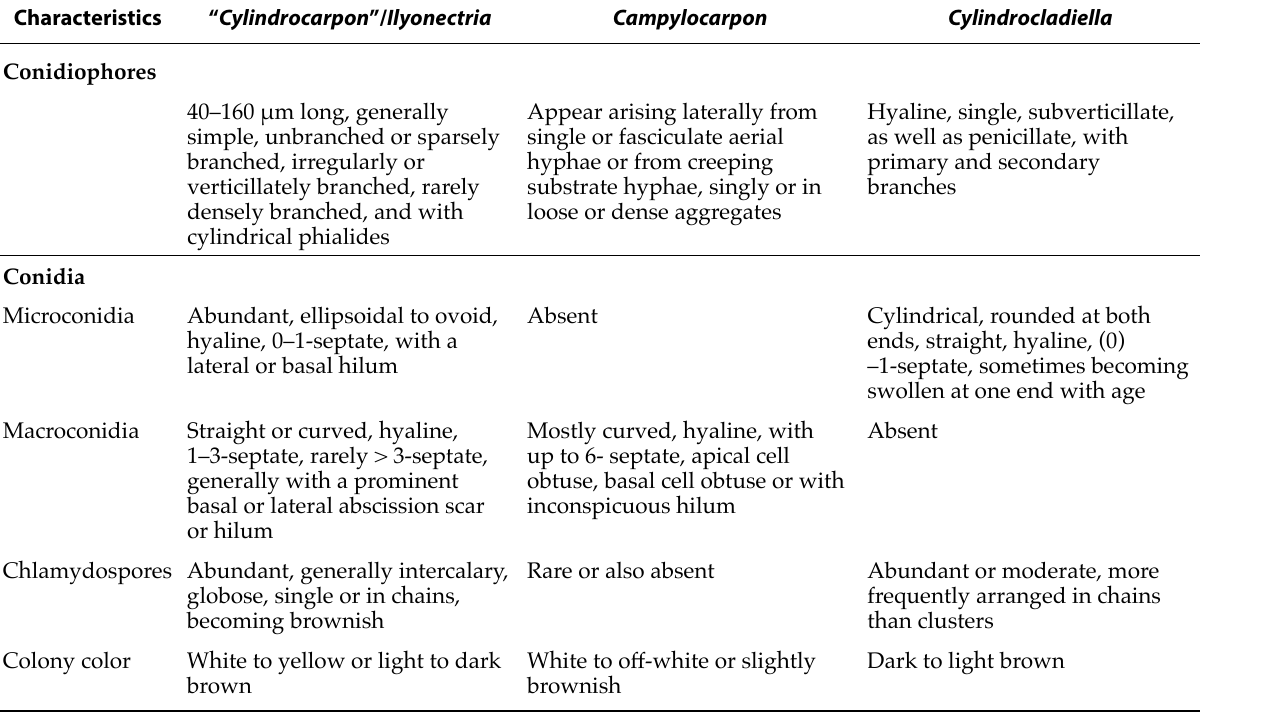
Table 2. Summary of distinctive morphological and cultural features of “ Cylindrocarpon ”/ Ilyonectria , Campylocarpon and Cylindrocladiella genera associated with black-foot disease of grapevines.